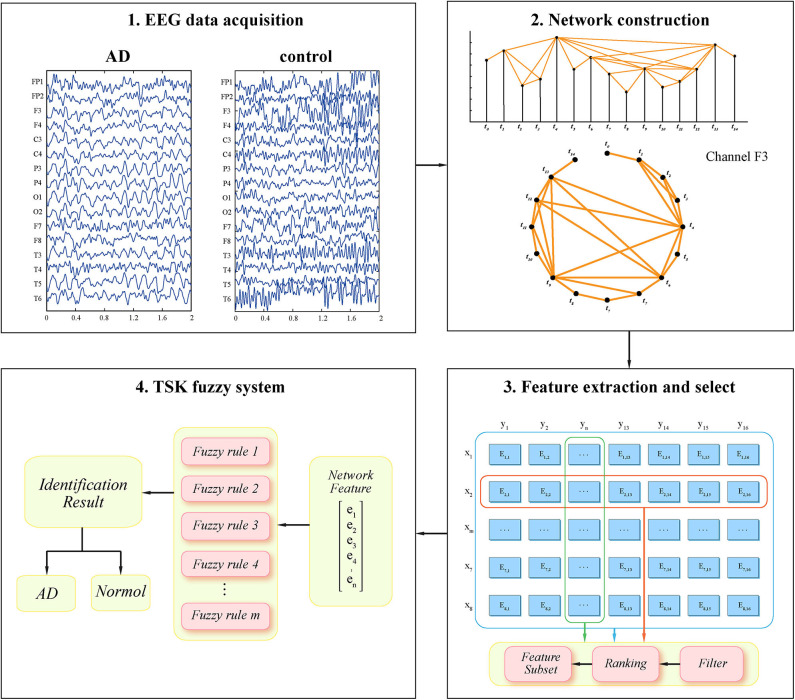
The framework of our method for classifying the AD patients in EEG signals. First multichannel EEG signals of two types of subjects are acquired and a preliminary analysis was performed. Second, we construct the WVG network based on each EEG channel. Third, the features are extracted and further ranked based on feature select method. Finally, we combine the network theory with a fuzzy rule-based system to identify AD pattern with the selected network topological properties.